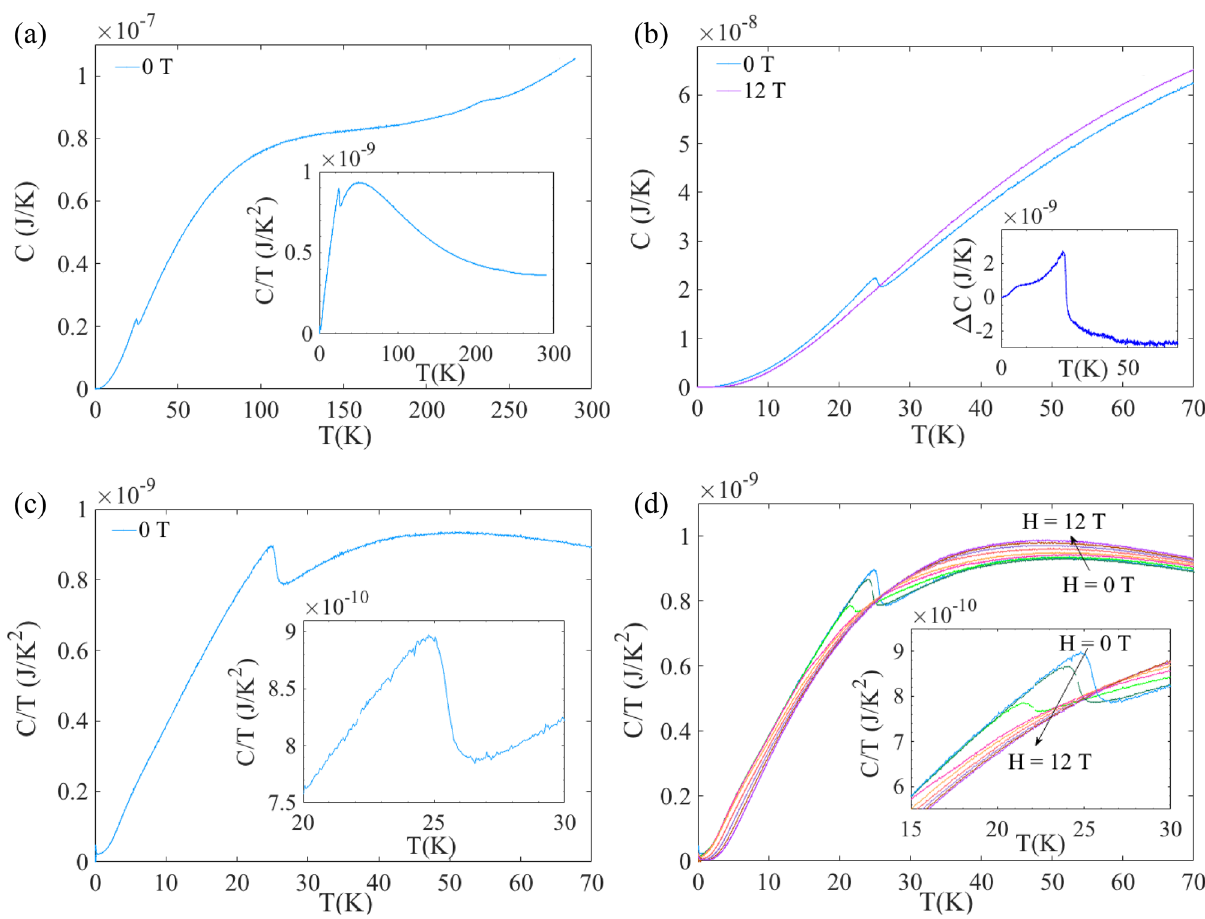
Figure 5. ( a ) Temperature dependence of Specific heat C(T) of GdAu 6.75−x Al 0.5+x recorded under zero magnetic field. Inset shows the C/T versus T plot of the main panel. ( b ) C(T) curves recorded under two extreme magnetic fields i.e. H = 0 T and H = 12 T; their difference ΔC is plotted in the inset. C/T versus T curves for ( c ) H = 0 T, ( d ) H = 0, 1, 2, 3, 4, 6, 8, 10 and 12 T. Insets of bottom panels show the zoomed view of corresponding main